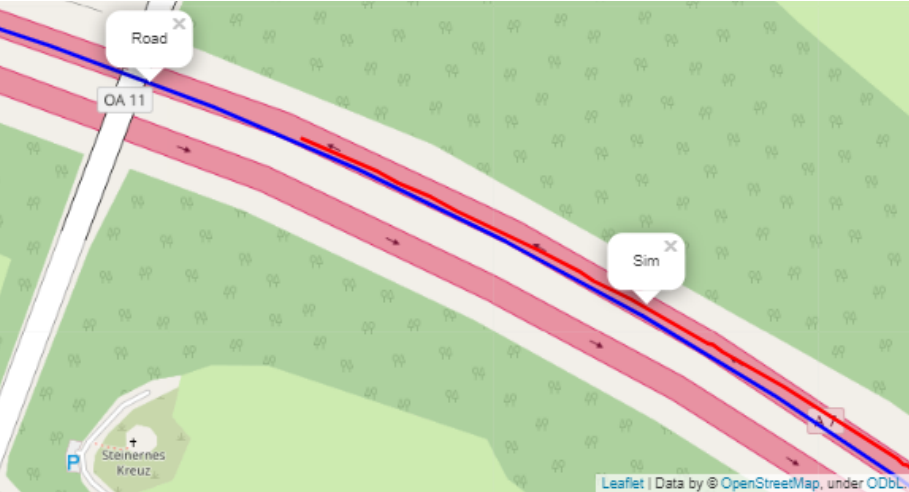
Figure 5. Vehicle trajectories from an exemplary real test drive (Road) and a simulation (Sim) at the validation scenario v x = 169km/h and a y , ref = 0.85 a y , smax , located on a OpenStreetMap of the · German motorway A7. These trajectories of the vehicle’s center of gravity are shown at this point for illustration purposes, but not to derive detailed distances from the vehicle edges to the